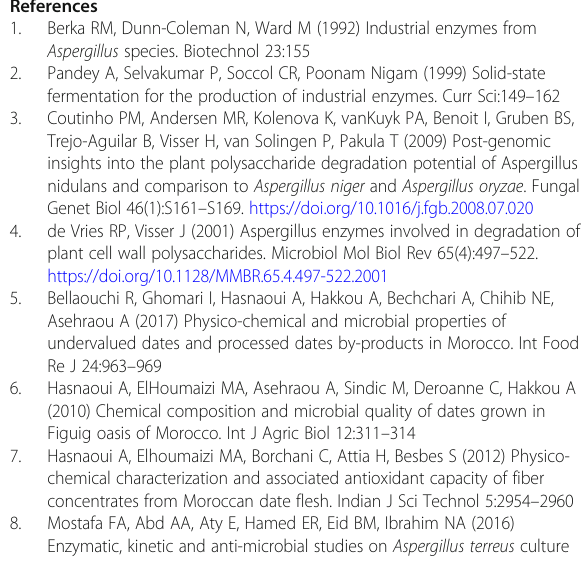
Figuig oasis of Morocco. Int J Agric Biol 12:311 – 314